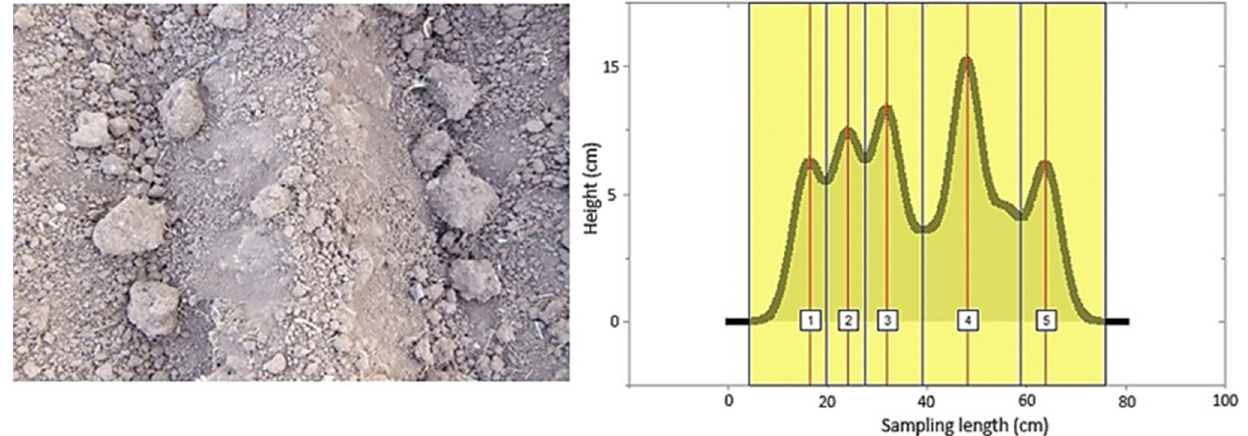
Figure 10. Irregular plow layers with the detection of peaks corresponding to the plow layers.